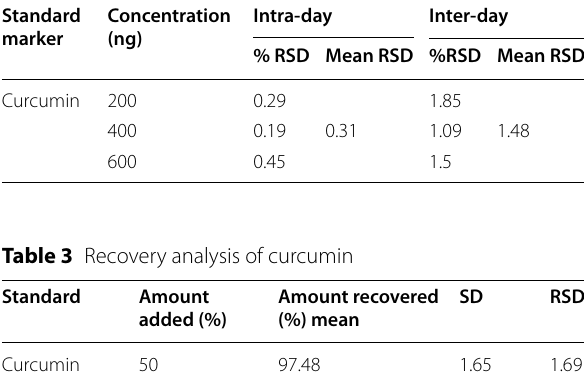
Table 1 Statistical parameter for linearity validation of curcumin